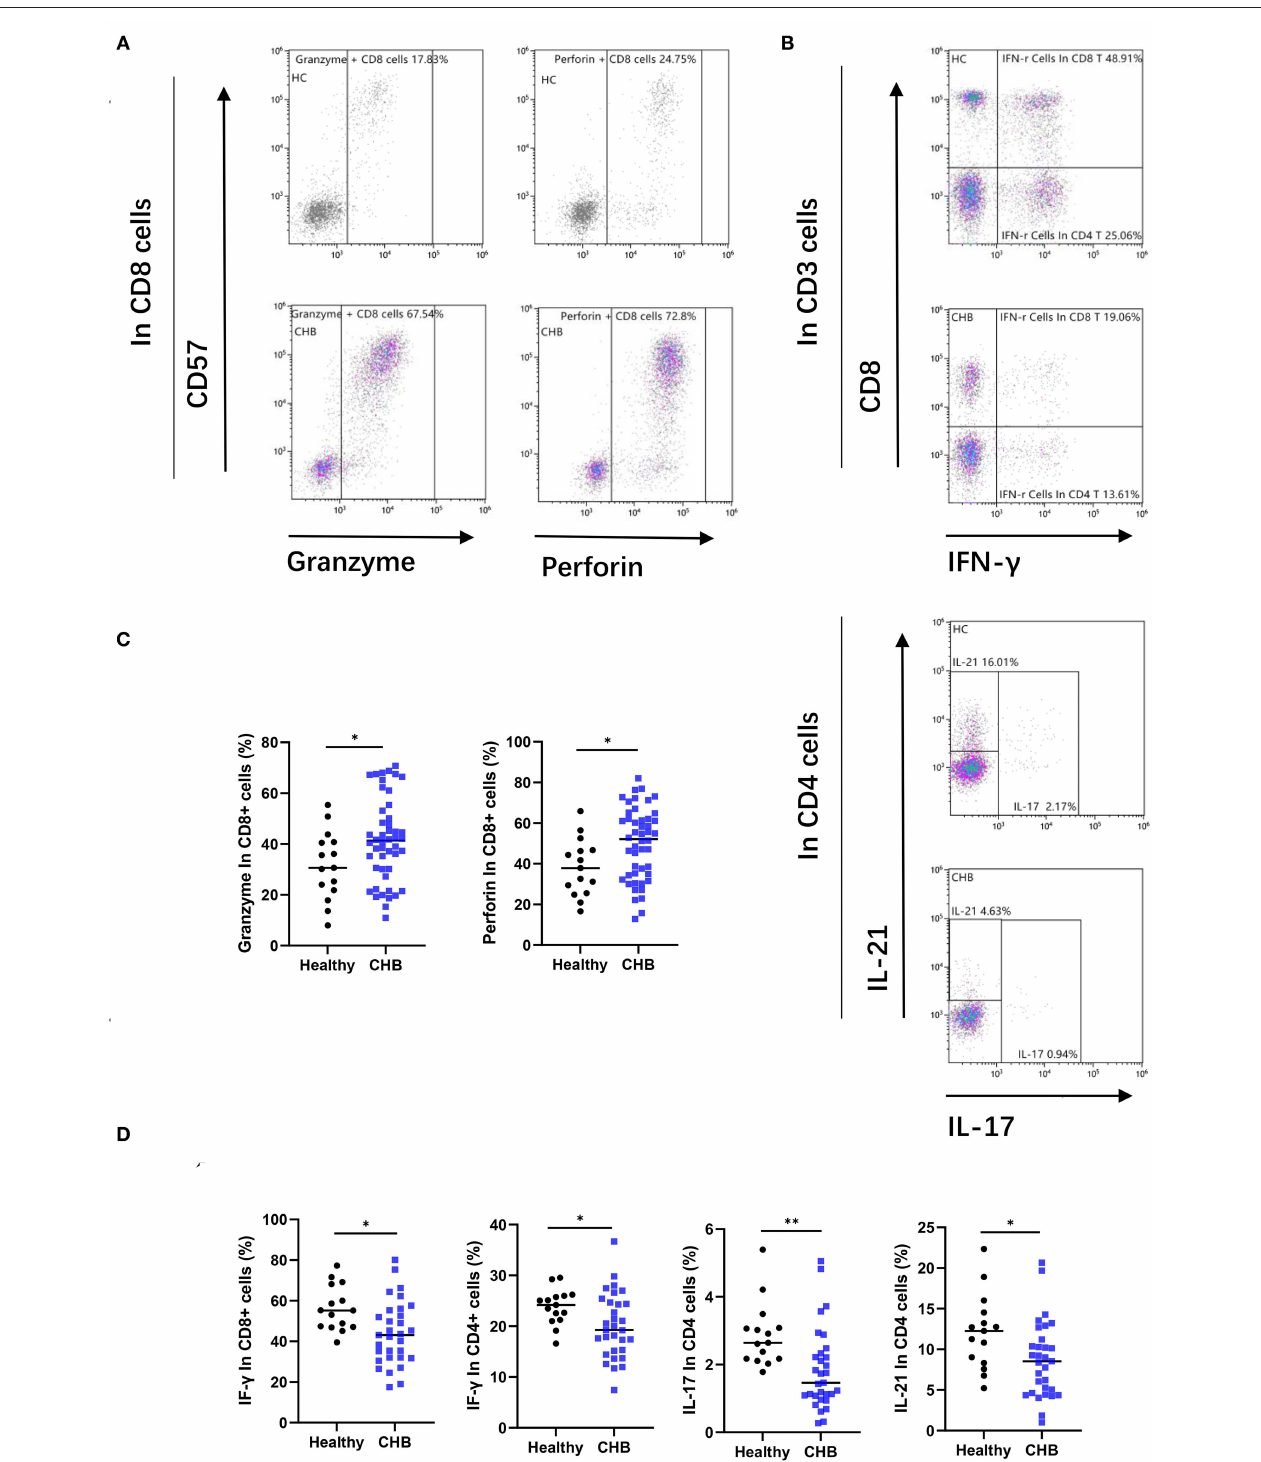
FIGURE 5 | Chronic hepatitis B (CHB) patients show functional alteration in T cells. (A) Representative flow-cytometry plots, as well as the proportion of granzyme and perforin in CD8 + T cells, are shown. (B) Peripheral blood mononuclear cells (PBMCs) from healthy controls and CHB patients were incubated for 3h after stimulating by specialized tubes containing stimulating agents (PMA) and ionomycin. The proportion of CD8 + CTL cells positive for IFN-r and the gating strategy for analyzing the cytokine secretion capacity of CD4 + TH cells are shown in representative flow-cytometry plots. (C) Comparison of granzyme and perforin expression in CD8 + cells in healthy controls ( n = 15) and CHB patients ( n = 48). (D) Comparison of the functions of various types of cytokine secretion by T cells subset between healthy controls ( n = 15) and CHB patients ( n = 31).